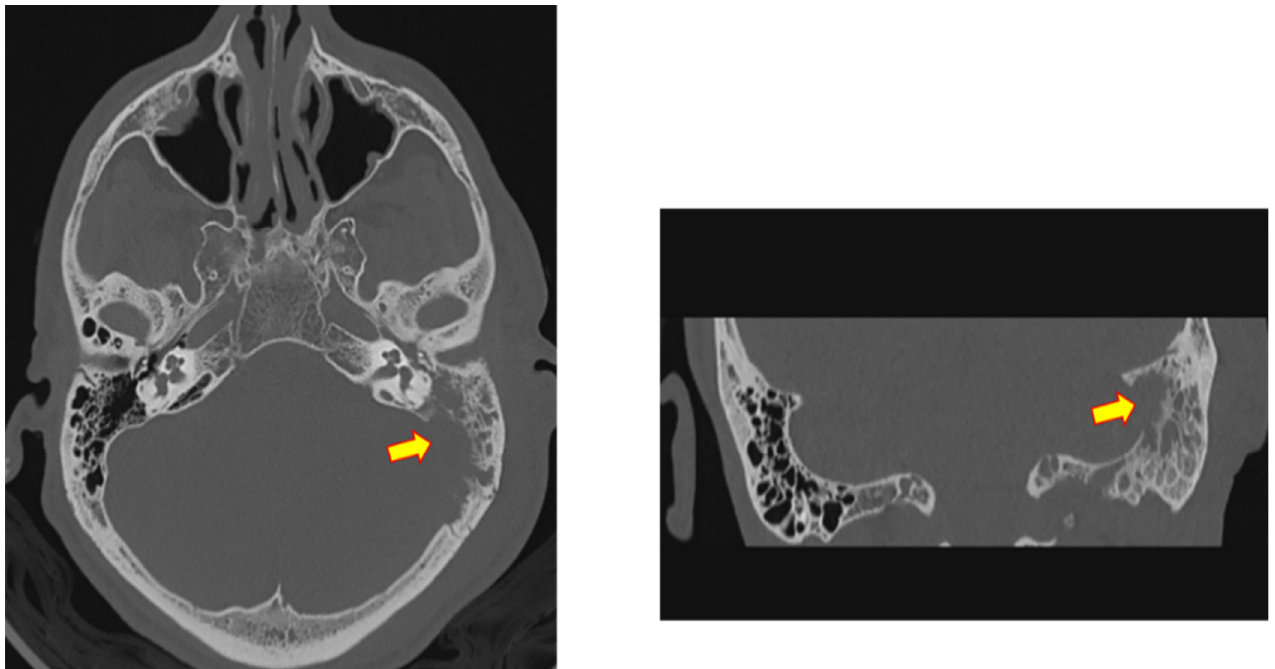
Figure 1. Pre-operative CT scan—case 1. Axial high-resolution temporal bone CT scan and coronal reconstruction show extensive bone destruction at the medial and posterior aspects of the left mastoid bone. Mastoid, middle ear, and external auditory canal are opacified—see yellow arrows).